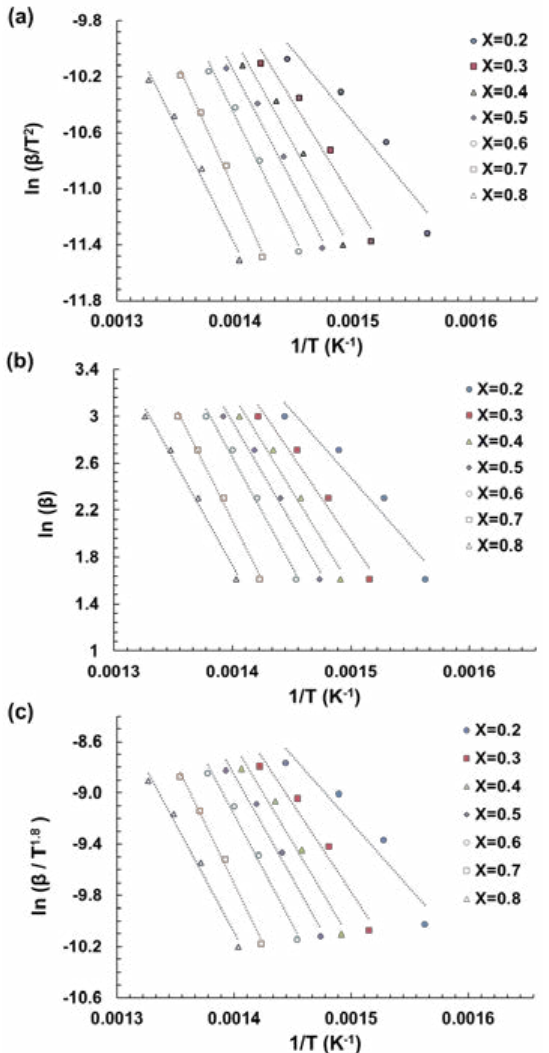
Fig. 5: Linear regression lines; (a) KAS, (b) OFW, and (c) Starink at various conversions (X)